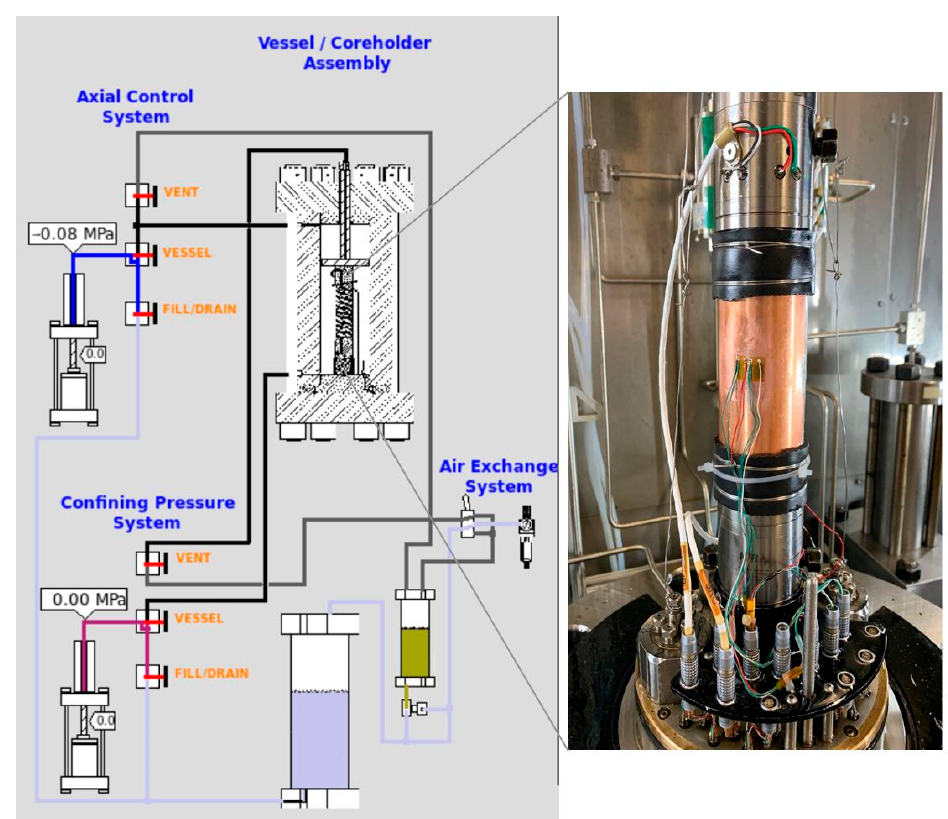
Figure 2. Triaxial experimental setup to pressurize the sample with confining and axial stress. An inset with a fully connected sample is shown.